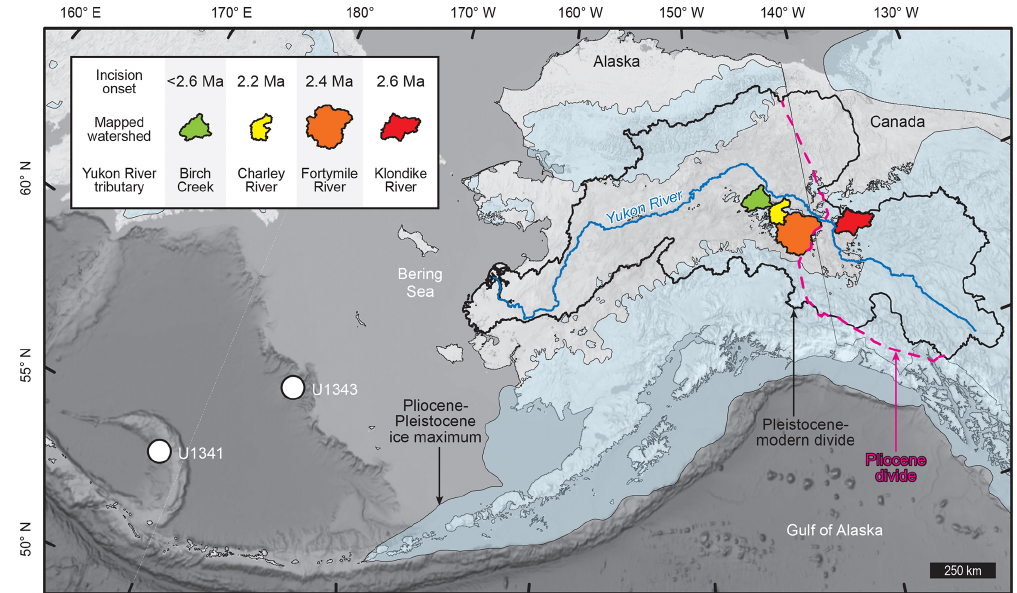
Figure 1. The Yukon River–Bering Sea system. Overview depicts the modern (black line) and Pliocene (magenta line; Duk-Rodkin et al., 2001) Yukon River divide, Pliocene–Pleistocene maximum ice extent (Kaufman et al., 2011; Duk-Rodkin et al., 2001), Integrated Ocean Drilling Program (IODP) core sites (white circles; März et al., 2013; Horikawa et al., 2015; Iwasaki et al., 2016; Onodera et al., 2016; Kim et al., 2016). Birch Creek (Ager et al., 1994), Klondike (Hidy et al., 2013, 2018; Westgate et al., 2003; Lowey, 2006), Fortymile (Bender et al., 2020), and Charley River watersheds colored by incision onset timing. Base map is the general bathymetric chart of the oceans (GEBCO) grayscale rendering (https://www.gebco.net/data_and_products/gridded_bathymetry_data/gebco_2021/, last access: 24 October